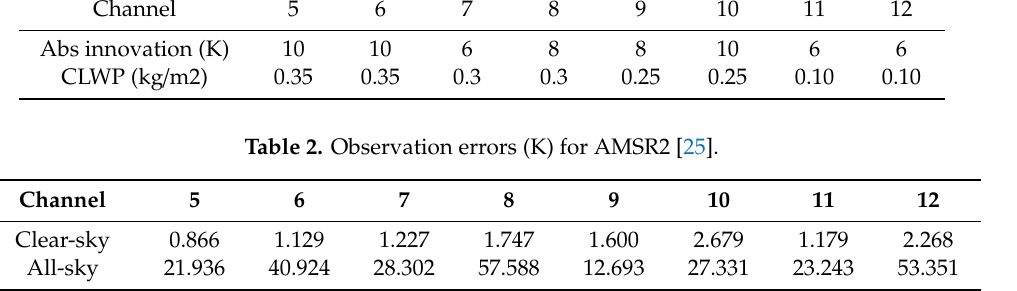
Table 1. Quality-control thresholds.